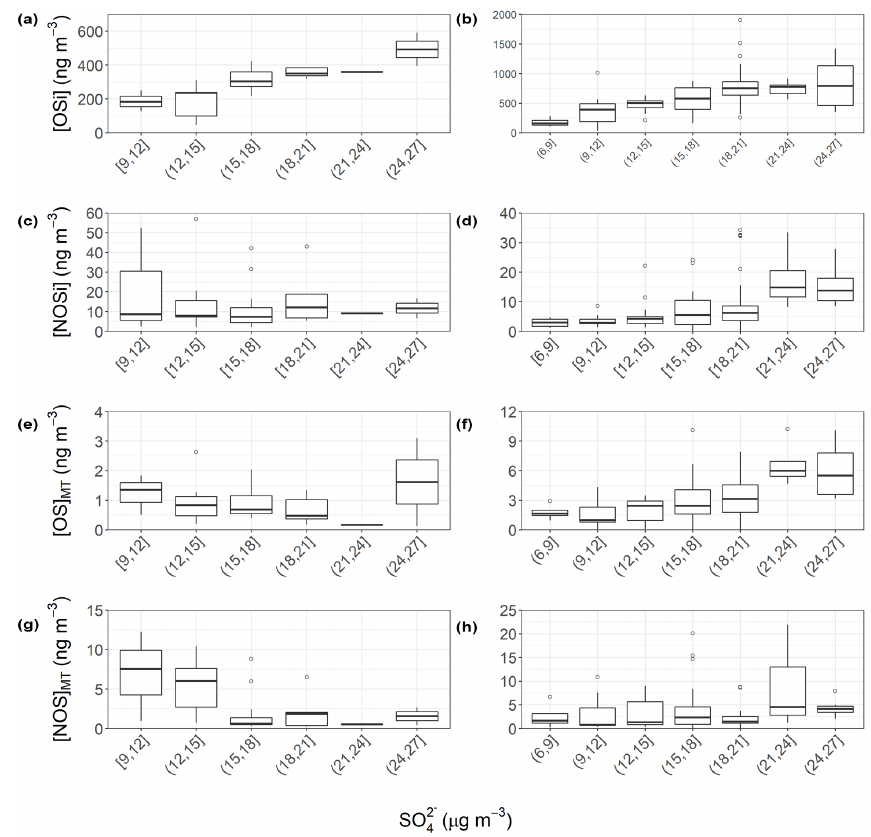
Figure 8. Quantified SOA (OS i , NOS i , OS MT , NOS MT ) vs. inorganic sulfate concentrations across the pre- (a, c, e, g) and post-monsoon (b, d, f, h) campaigns. The lower and upper parts of the box represent the 25th and 75th percentiles, with the upper and lower lines extending no further than 1.5 times the interquartile range of the highest and lowest values within the hinge, respectively. Only species identified in more than 40% of the samples for each campaign were